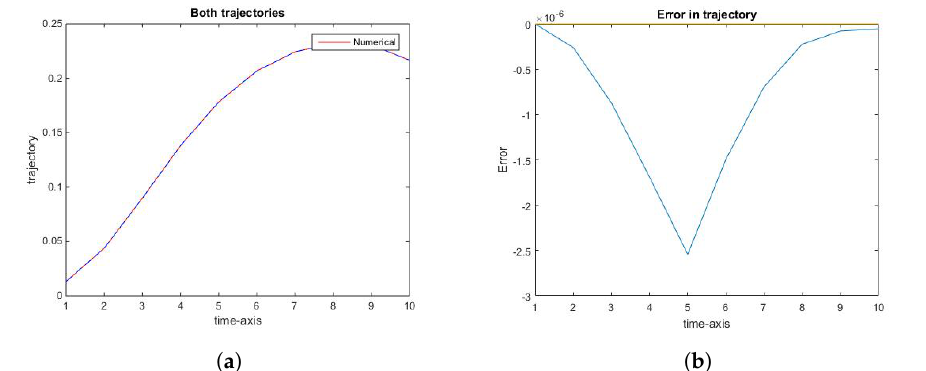
Figure 5. Accuracy of the Nash equilibrium trajectory. ( a ): The trajectories of numerical (red) and actual (blue dashed) state variable, X ( t ) , for the Nash equilibrium; ( b ): The error in the trajectory of the state variable, X ( t ) , for the Nash equilibrium.